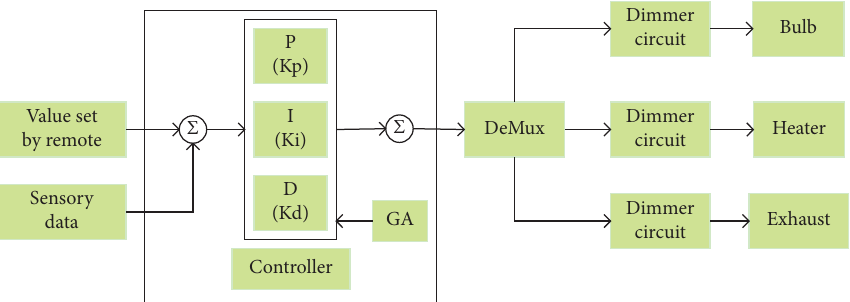
Figure 5: GA with PID controller for home